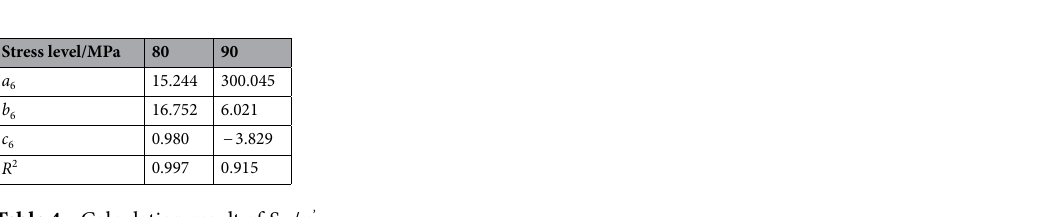
Table 4. Calculation result of S 11 / η ’ 2